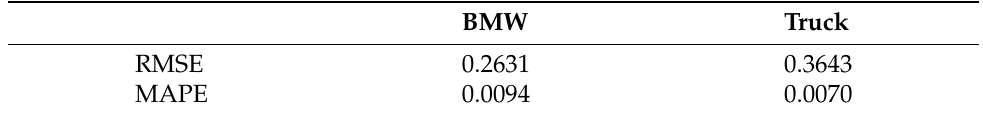
Table 1. Error metrics for the example